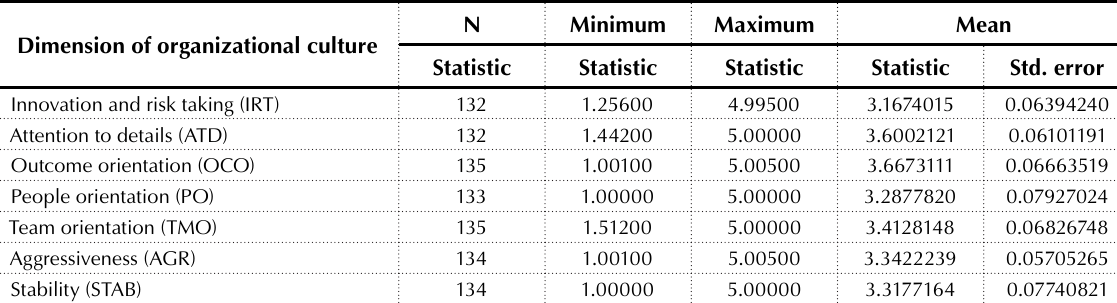
Table 1. Mean values for organizational culture Dimension of organizational culture